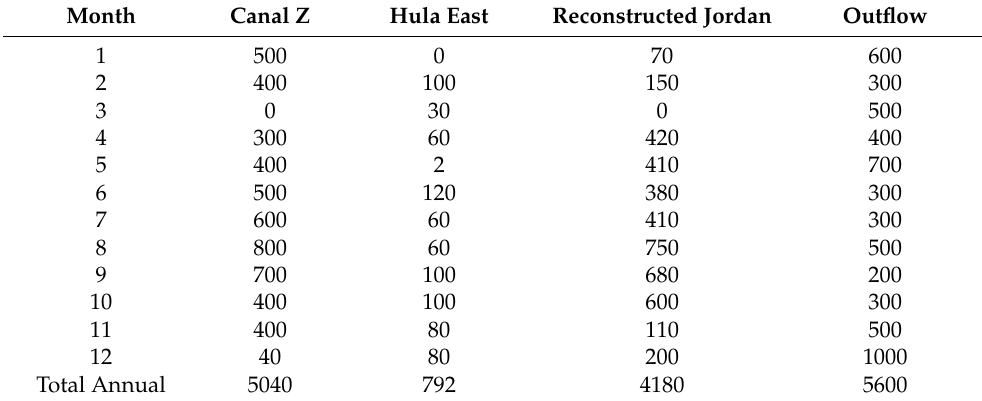
Table 6. Monthly discharges (10 3 m 3 ) of water inflows through the sources into Lake Agmon: Canal Z, Hula East, and Reconstructed Jordan during 2003.